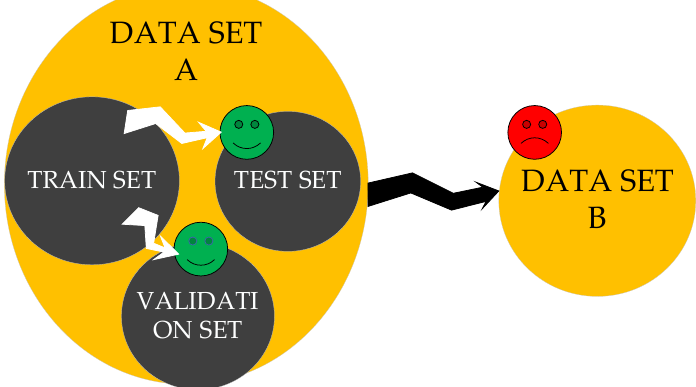
Figure 1. Sketch of poor extrapolation of the predictive model. Among the many optimization methods, the regularization technique using an addi- tional weight attenuation term in the error function of BPNN can appropriately fix the overfitting problem [17]. Bezazi et al. combined BPNN with the Bayesian technique to predict fatigue probability life, and the results showed that Bayesian training could obtain better data fitting performance [17]. The so-constructed model is a Bayesian regularized backpropagation neural network (BR-BPNN). In order to evaluate the significance of input parameters, researchers investigated different methods. Garson [24] and Li et al. [25] analyzed the influence weight of each input variable based on the weight matrix, which could be applied to the single and dou- ble hidden layer neural network, respectively. Lopes et al. [26] took the contribution factor as a guide to screen input variables, calculated by the sum of the weights connected to an input variable. In addition to the weight matrix, scholars also use multiple linear regres- sion (MLR) to explain the significance of input variables, taking the significance output of MLR as the input of neural networks [27 – 29]. This method can also identify the direction of parameter influence (positive or negative correlation), achieving satisfactory results based on linear and additive correlation. Therefore, this study aimed to validate whether a successful fatigue life analysis for concrete flexural fatigue based on existing data could also be obtained with BPNN. For the common problem of localized optimization with BPNN, the Bayesian regularization optimization [30] was constructed with MATLAB to improve the accuracy of fatigue life prediction. One novelty of this study is its use of a separate data set when verifying the model’s generalization capability. Since there is no currently available mathematical as- sessment of the importance of various factors related to concrete fatigue life [31], the av- erage relative impact value (ARIV) was proposed as a quantitative index. Its use was ver- ified through the comparison with the weight equation and MLR method. Based on the data from the literature [32 – 35], the BR-BPNN with satisfactory generalization capability for concrete flexural fatigue was obtained and then applied to predict flexural fatigue life curves under various parameters. Finally, to investigate whether a significant discrepancy exists between fatigue properties under different loading conditions [36], the fatigue life of plain concrete in splitting tension, axial tension, and flexure loading was analyzed through BR-BPNN. 2. Materials and Methods 2.1. Data Collection and Preprocessing In fatigue experiments, the recordable parameters mainly include R, Smax, P, f, wa- ter-cement ratio (W/C), sand-cement ratio (S/C), and gravel-cement ratio (G/C). It should